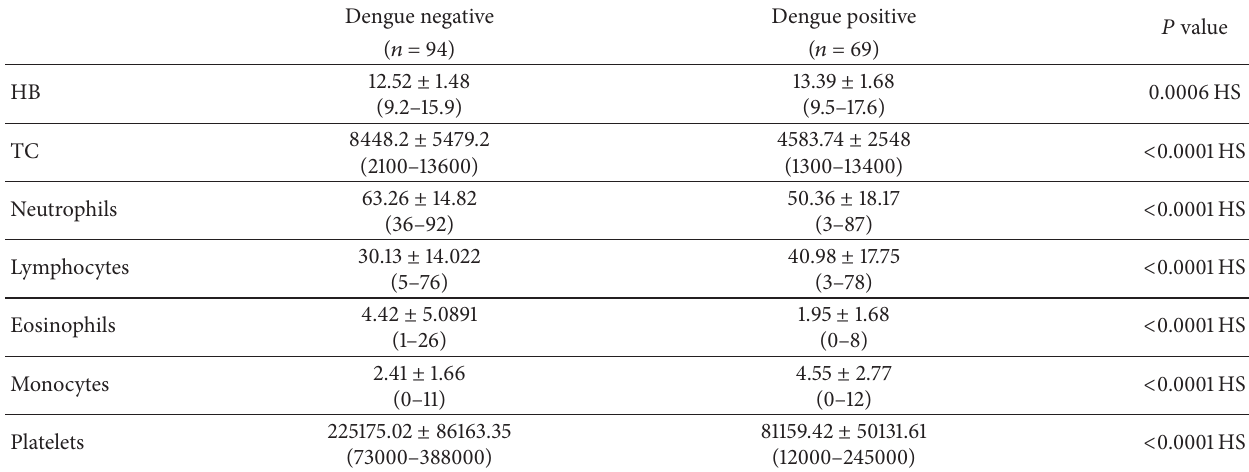
Table 2: Alterations in haematological parameters in dengue-positive and dengue-negative paediatric cases.